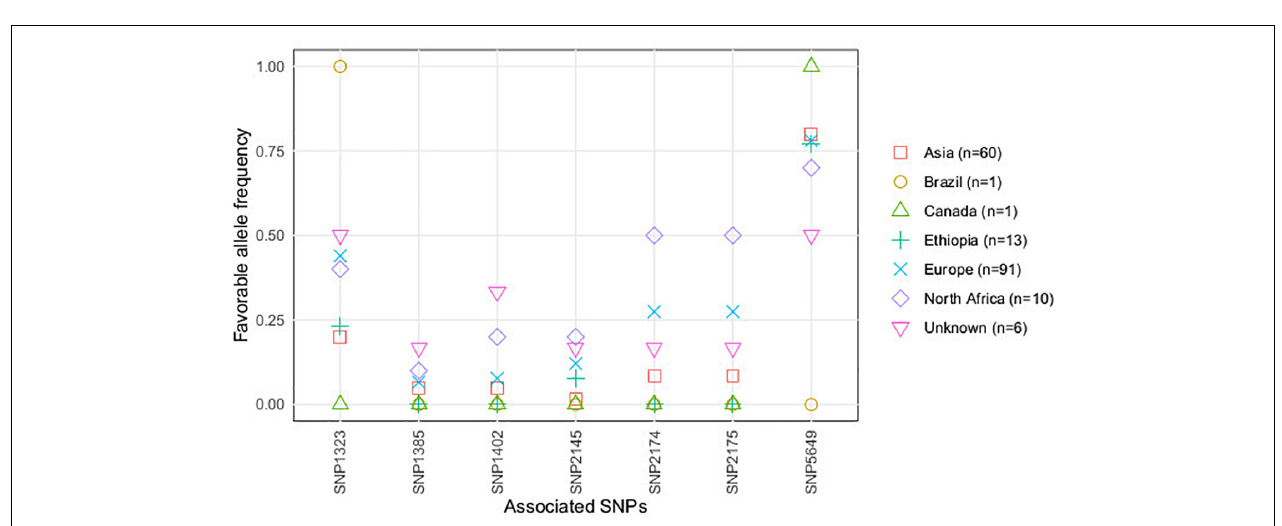
FIGURE 2 | Manhattan plot depicting the –log 10 ( P -value) vs. chromosomal position of 5,651 SNP markers associated with the disease response of a grass pea collection of 182 accessions infected with U. pisi . The red line shows the threshold –log 10 ( P -value) = 3.5 for the detection of significantly associated genomic regions.